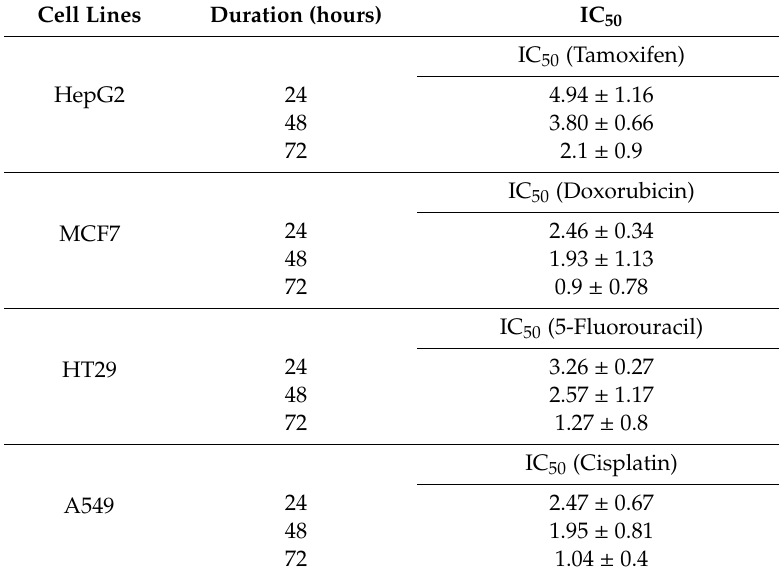
Table 3. IC 50 of Tamoxifen, Doxorubicin, 5-Fluorouracil and Cisplatin on HepG2, MCF7, A549 and HT29 after 24, 48 and 72 h of